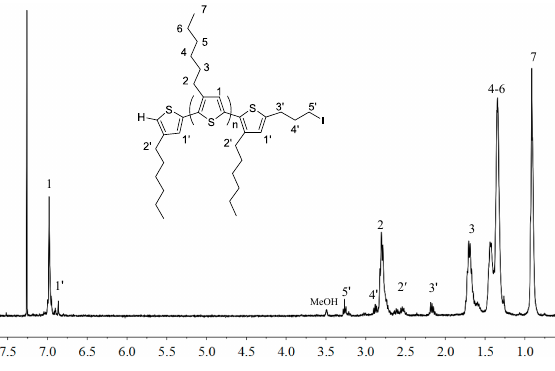
Figure 2. 1 H-NMR (400 MHz, CDCl 3 ) spectrum of P3HT-(CH 2 ) 3 I with MW = ~2000 g/mol.